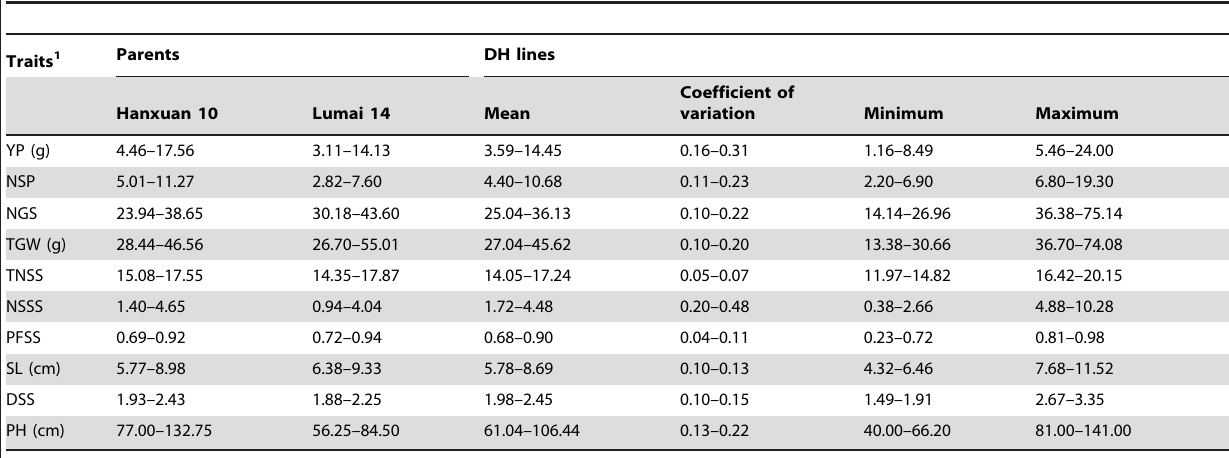
Table 1. Phenotypic distributions of yield-associated traits in the wheat parents and DH lines across different environments.